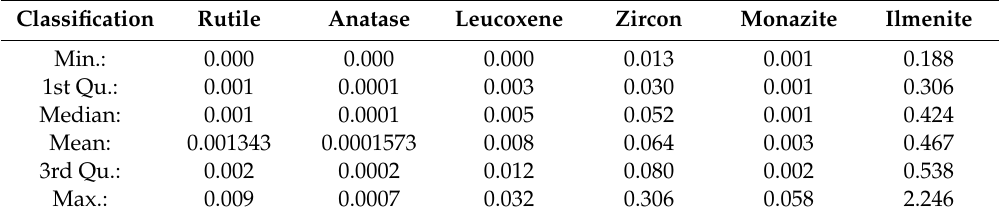
Table 1. Statistical attributes of the weight percent of each heavy